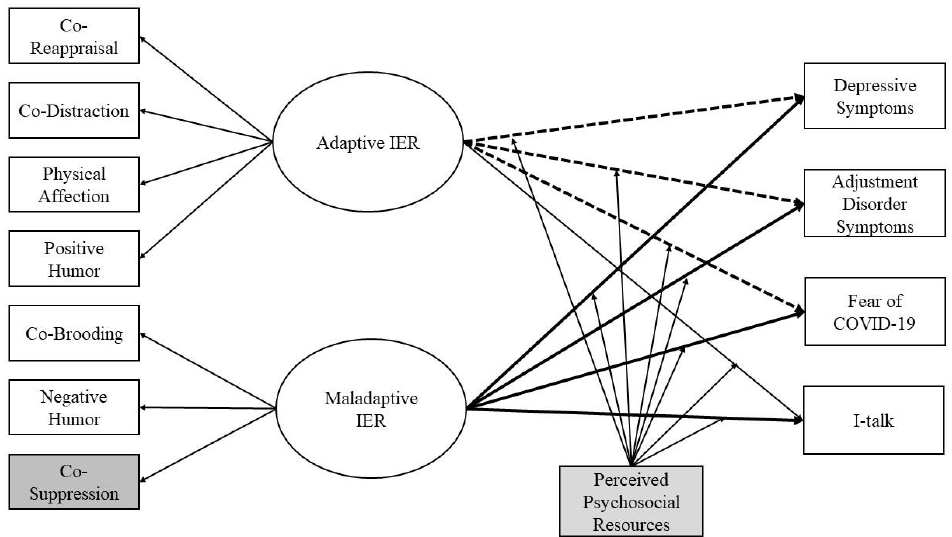
Figure 1. Conceptual Model. Note . IER = Interpersonal emotion regulation. The paths between IER and the affective symptom outcomes were all further controlled for age, sex, country, prior mental health diagnosis, social support, attachment style, loneliness, trust in others, and in model 1b additionally, intrapersonal emotion regulation strategies of brooding and reappraisal. Co-suppression (displayed in grey) was later excluded from the model because it did not load sufficiently on the latent variable (<0.40). The bold lines represent significant paths above and beyond intrapersonal emotion regulation, the dotted lines represent significant paths only without controlling for intrapersonal emotion regulation (see Section 3). The interactions with perceived social resources (displayed in light grey) were added in later models for each social resource (social support, attachment style, loneliness, trust)